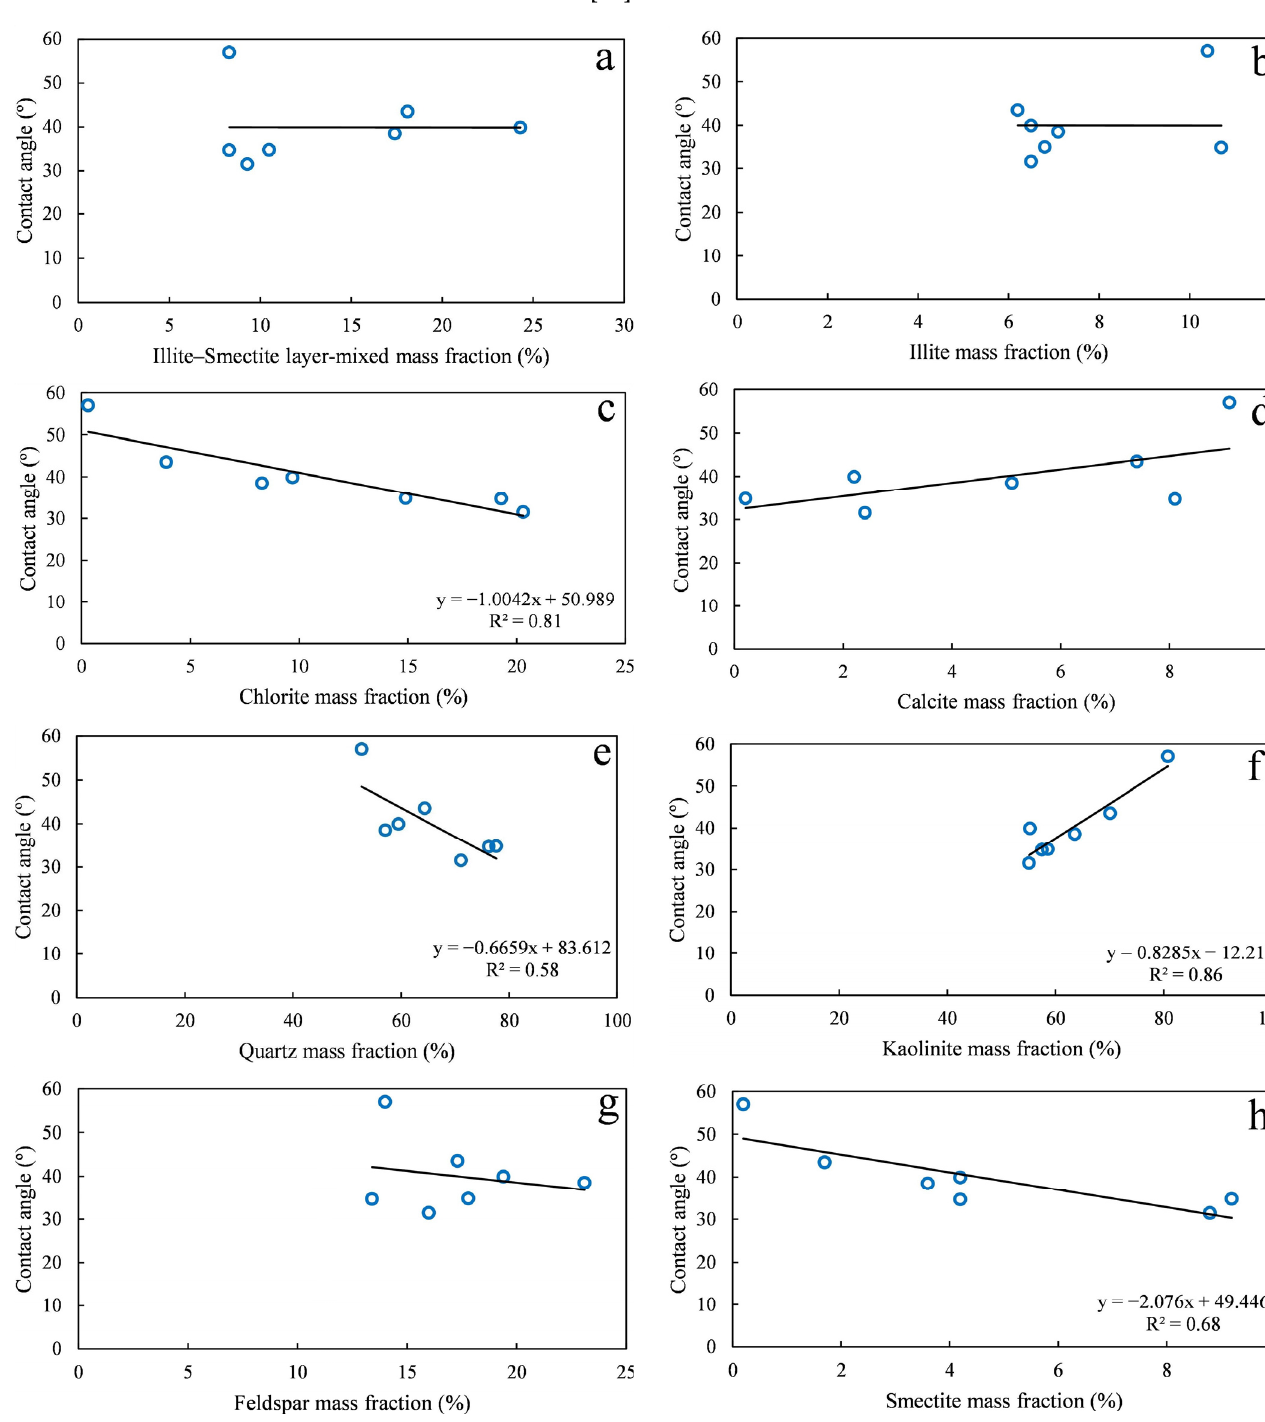
Figure 8. Relationship between the mass fraction of different minerals and the oil contact angle of samples: ( a ) Illite–Smectite layer-mixed, ( b ) Illite, ( c ) Chlorite, ( d ) Calcite, ( e ) Quartz, ( f ) Kaolinite, ( g ) Feldspar, ( h ) Smectite.